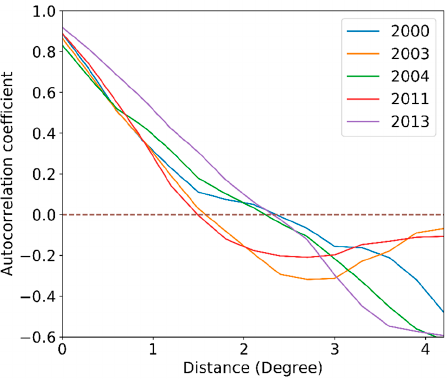
Figure 4. Precipitation anomaly percentage spatial correlogram.